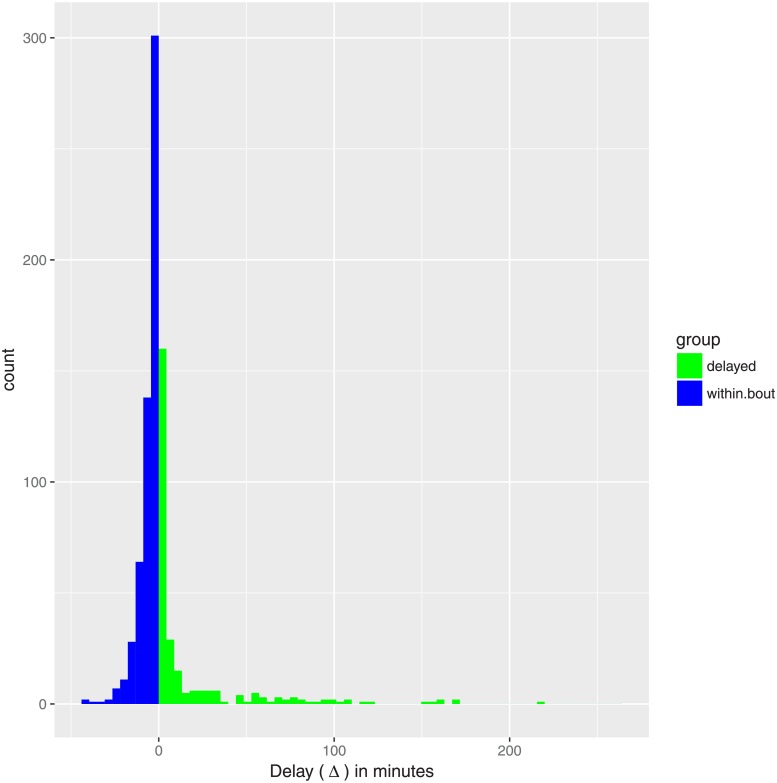
Histogram of Δ measured in minutes.